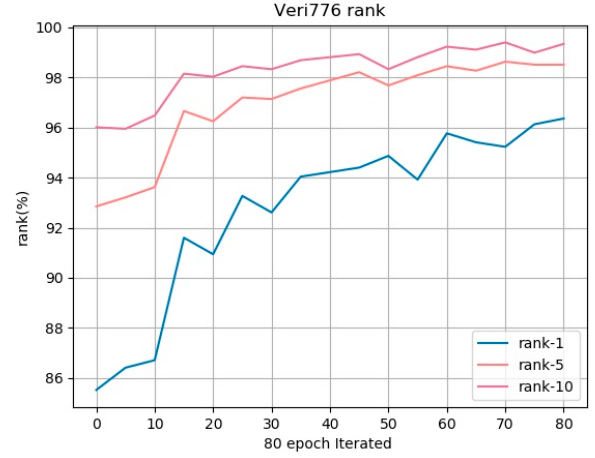
Figure 6. CMC curve of VeRi-776 dataset.